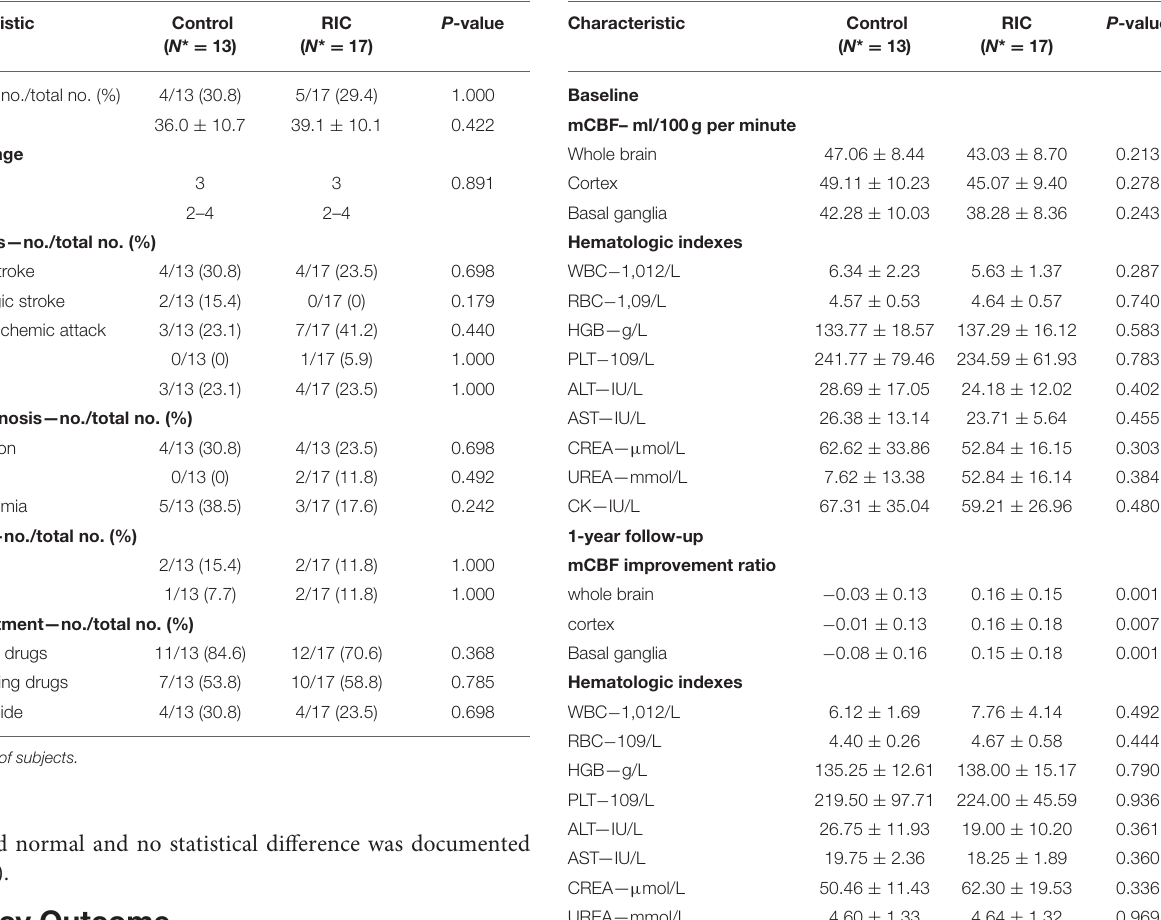
TABLE 2 | Features of hematologic indexes and cerebral blood flow.